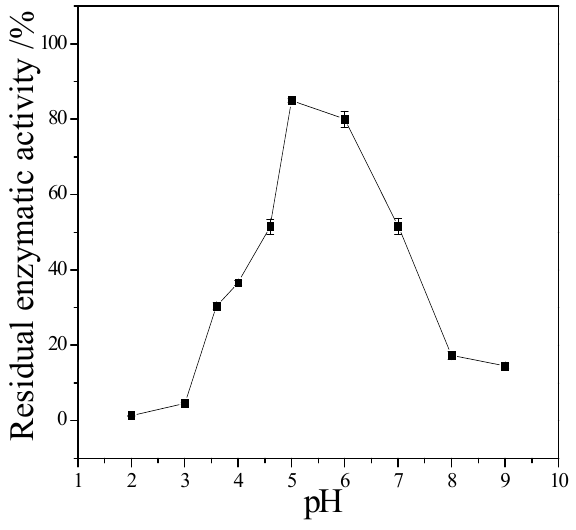
Figure 7. Stability of the cellulase to pH.